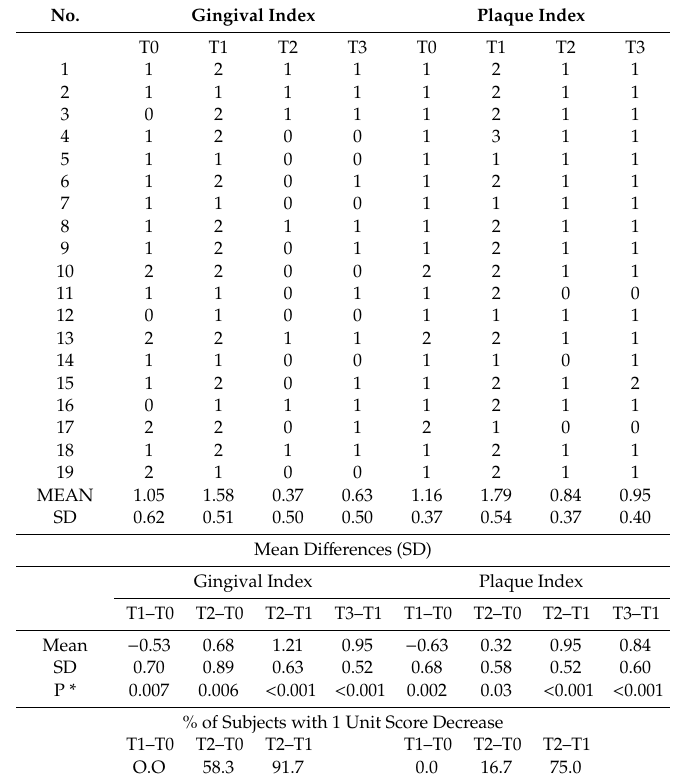
Table 2. Mean (SD) of gingival index (GI) and plaque index (PI) at T0, T1, and T2. No.